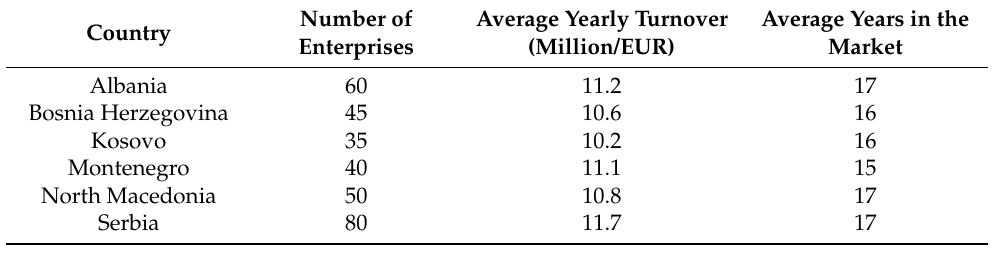
Table 1. Main characteristics of enterprises in the Western Balkan region according to the selection